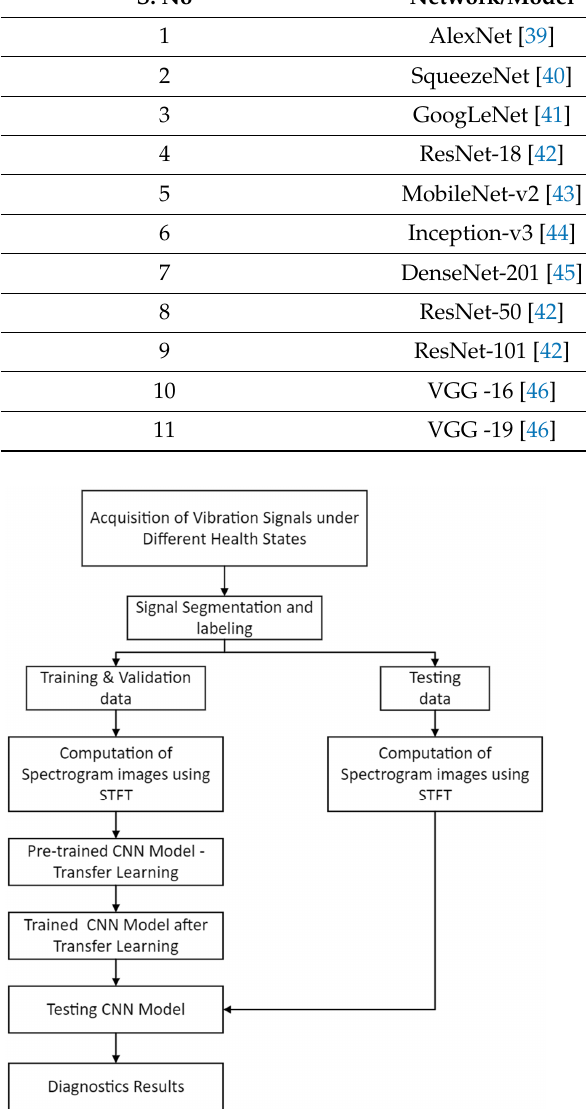
Table 3. CNN models.